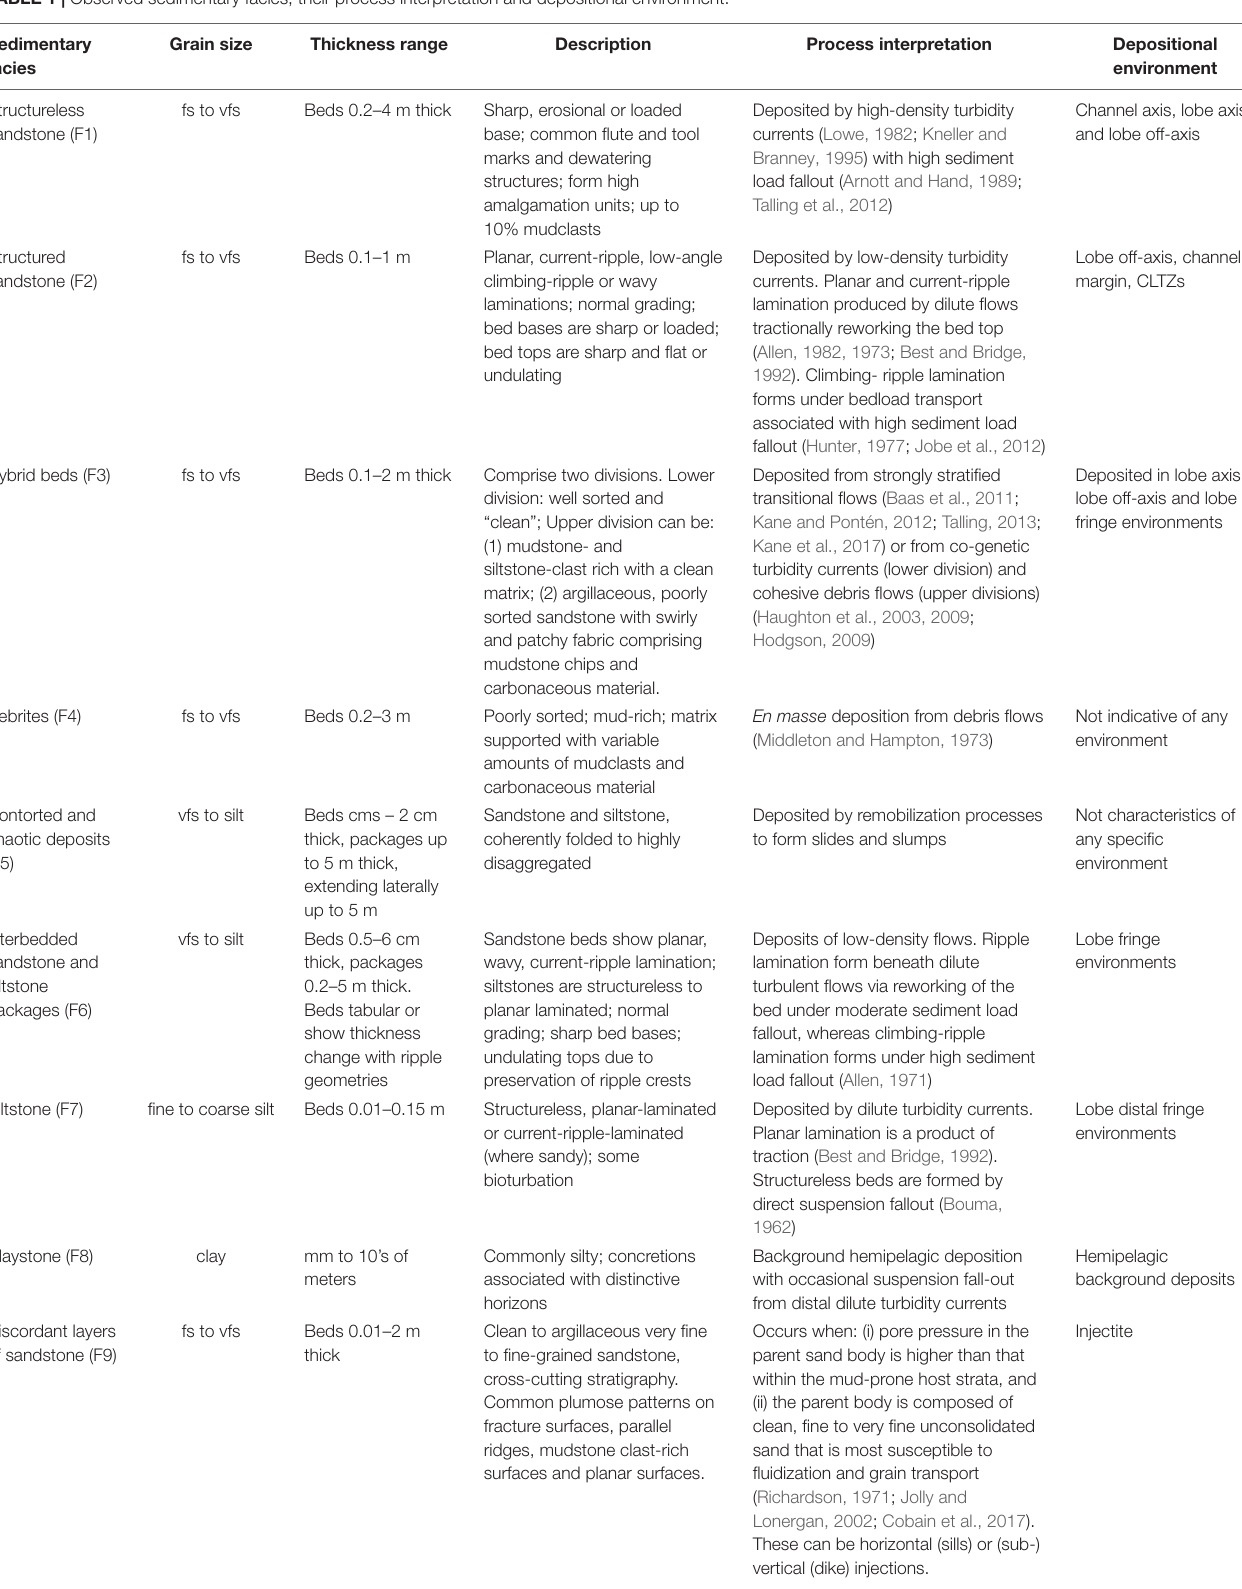
TABLE 1 | Observed sedimentary facies, their process interpretation and depositional environment. Sedimentary